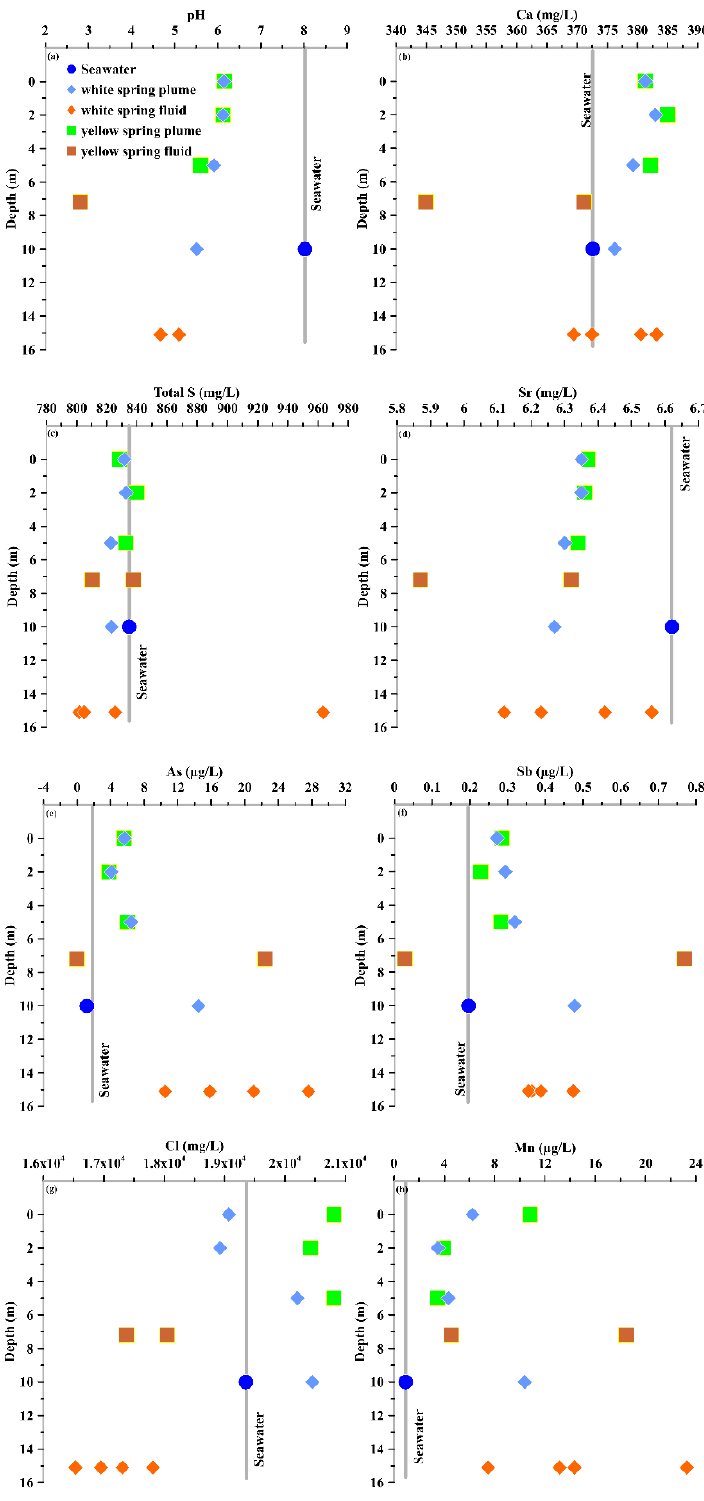
Figure 2. Changes in pH ( a ), Ca ( b ), total S ( c ), Sr ( d ), As ( e ), Sb ( f ), Cl ( g ) and Mn ( h ) concentrations from hydrothermal fluid to plume at the yellow and white spring sites. Compared with the Ca, Sr As and Cl concentrations in the yellow spring hydrother- mal plumes (381.3 to 385.0 mg/L, 6.34 to 6.37 mg/L, 3.81 to 6.01 µg/L and 20,422 to 20,814 mg/L), those in the white spring hydrothermal plumes have a slightly wider range of var- iation (376.2 to 383.0 mg/L, 6.27 to 6.35 mg/L, 4.08 to 14.5 µg/L and 18,925 to 20,454 mg/L)